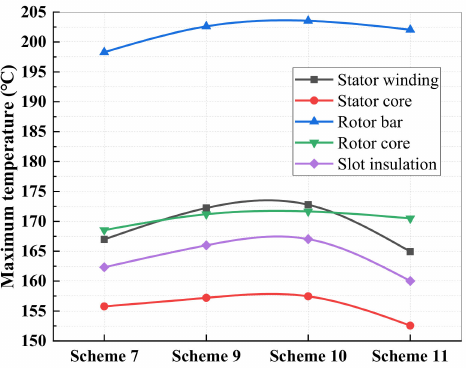
Figure 16. Temperature comparison under the scheme with varying cross-sectional diameter.